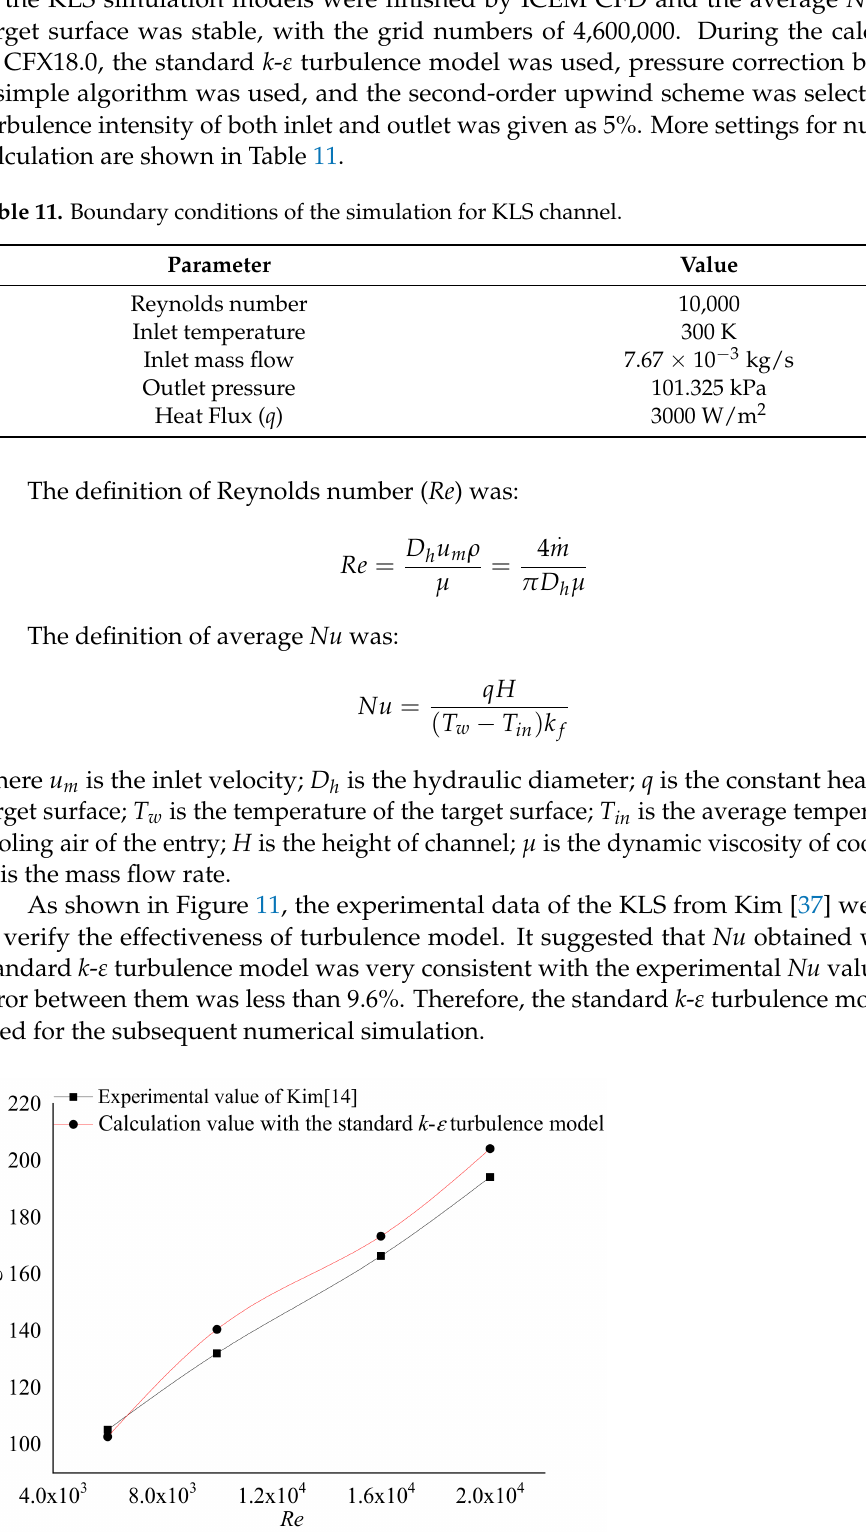
Figure 11. Validation of turbulence